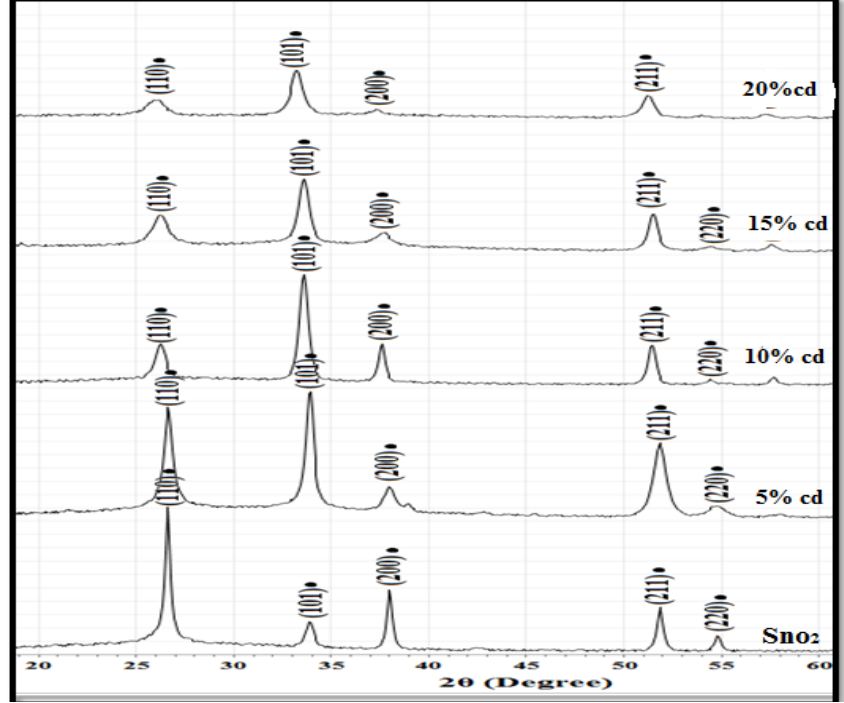
Fig.1: X-ray diffraction of SnO